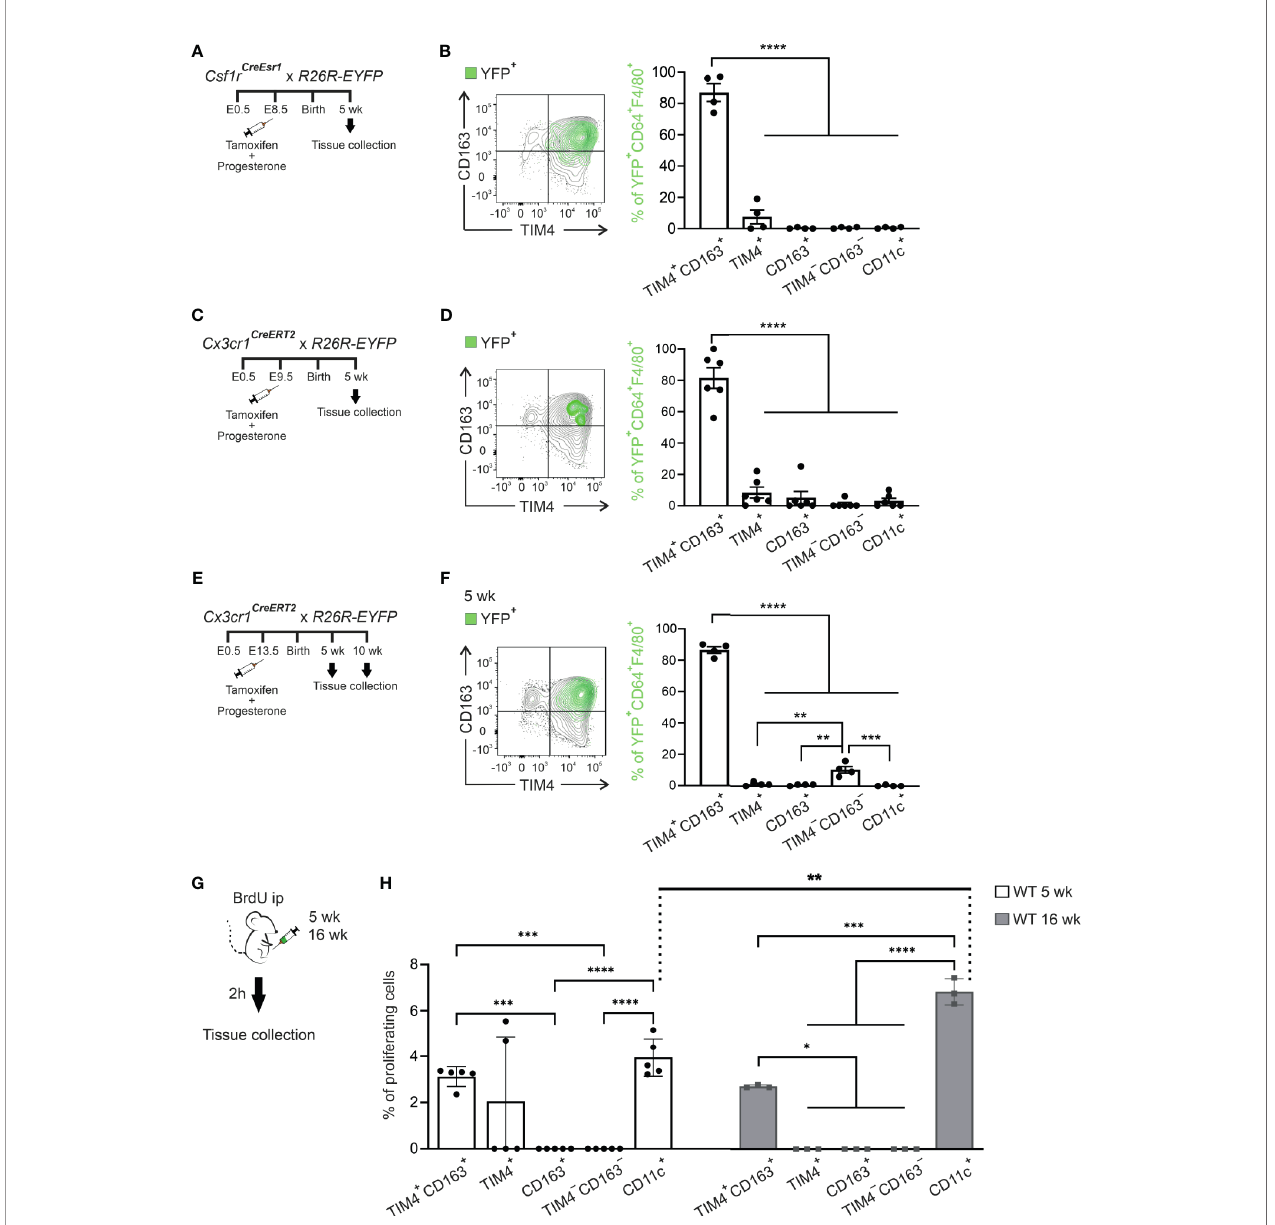
FIGURE 3 | Yolk sac-derived macrophages give rise to self-renewing tissue-resident ATMs. (A, B) The experimental outline (A) and representative FACS plot and kinetic quanti fi cations (B) of yolk sac ‐ derived macrophages in ATMs of Csf1r CreEsr1 ; R26R-EYFP mice. (C, D) The experimental outline (C) and representative FACS plot and quanti fi cations (D) of yolk sac ‐ derived macrophages in ATMs with the early conversion of Cx3cr1 CreERT2 ; R26R-EYFP reporter mice. (E, F) The experimental outline (E) and representative FACS plot and quanti fi cations (F) of yolk sac ‐ derived macrophages in ATMs of the Cx3cr1 CreERT2 ; R26R-EYFP mice with the late conversion of Cx3cr1 CreERT2 ; R26R-EYFP reporter mice. (B, D, F) The plots show the backgating of the YFP + cells (green) on the different ATM populations. The quanti fi cations show the frequency of CD45 + YFP + CD64 + F4/80 + cells in each macrophage population. (G) The experimental outline shows i.p. administration of BrdU to 5- and 16-week-old wild type (WT) mice and harvesting of ATMs after 2 hours. (H) Frequencies of BrdU positive cells in ATM populations. The quantitative data are shown as mean ± SEM [* P ≤ 0.0332, ** P ≤ 0.0021, *** P ≤ 0.0002, **** P ≤ 0.0001, one-way ANOVA (B, D, F) and two-way ANOVA (H) with Bonferroni post-hoc test]. Each data point represents one mouse. All fl ow cytometry data are from 2 ( B, D, F , and H for 5 wk) or 1 ( H for 16 wk) independent